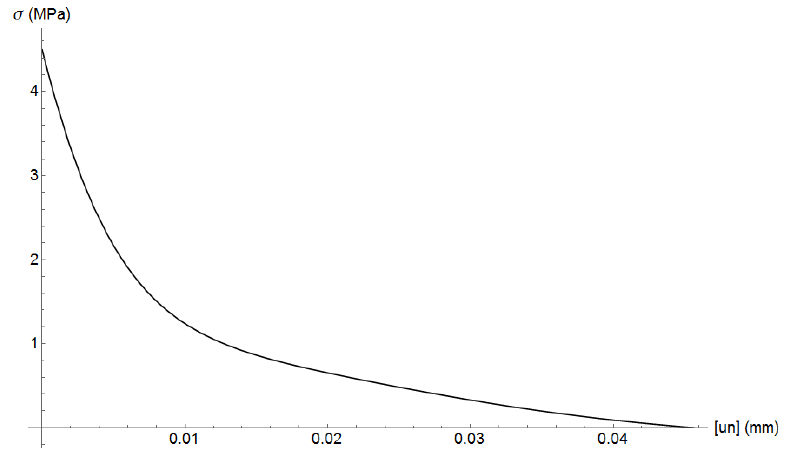
Figure 6. Mortar cohesive curve: tension stress versus crack aperture.